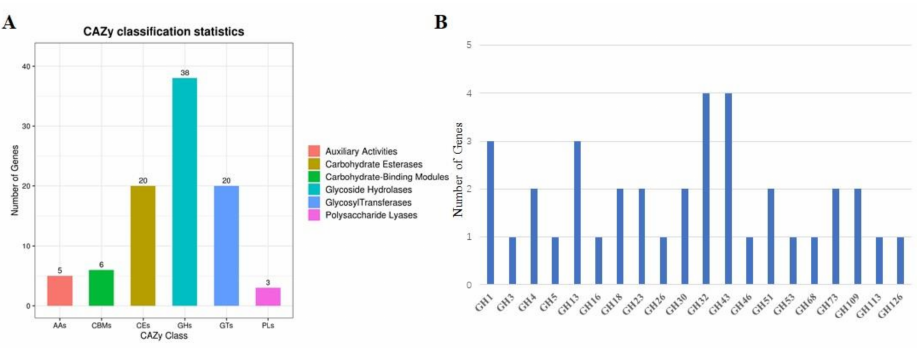
Figure 5. CAZy genes classification and glycoside hydrolase (GH) distribution in strain GS-1. ( A ) CAZy gene classification in GS-1 genome; ( B ) GH genes distribution in GS-1